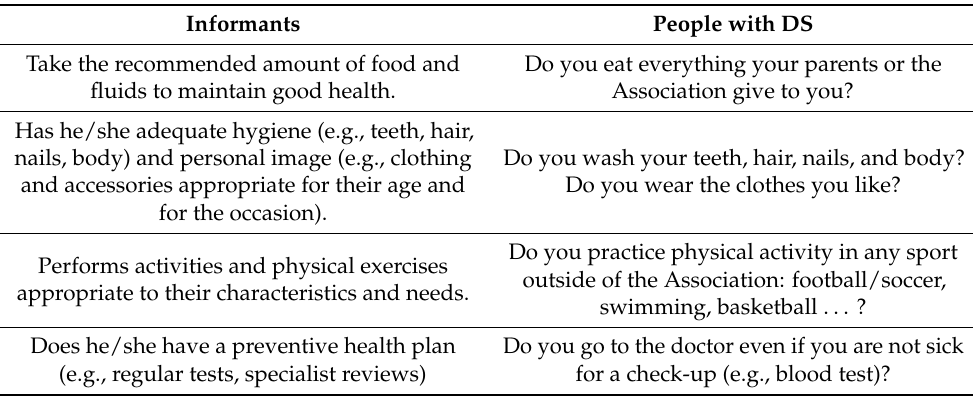
Table 1. Examples of questions for the informants and people with Down Syndrome (DS) view.